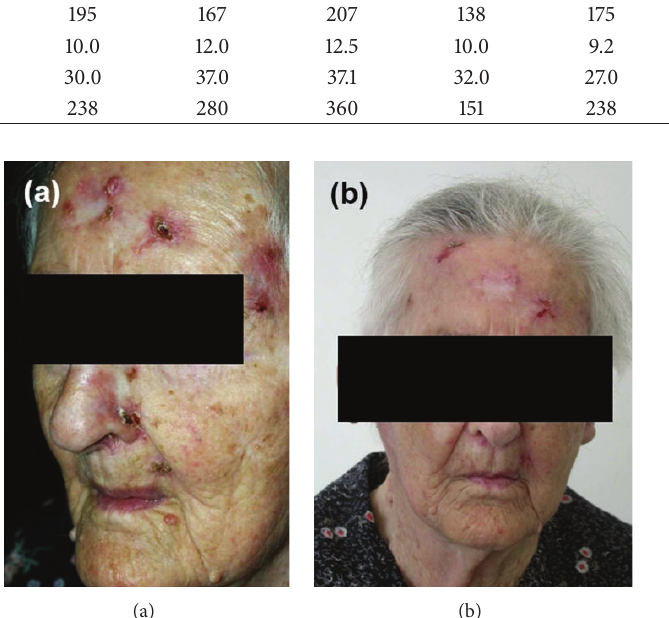
Figure 1: Patient 3. Forehead basal cell carcinoma lesions before everolimus treatment (a) and after six months of everolimus 3 mg daily (b).